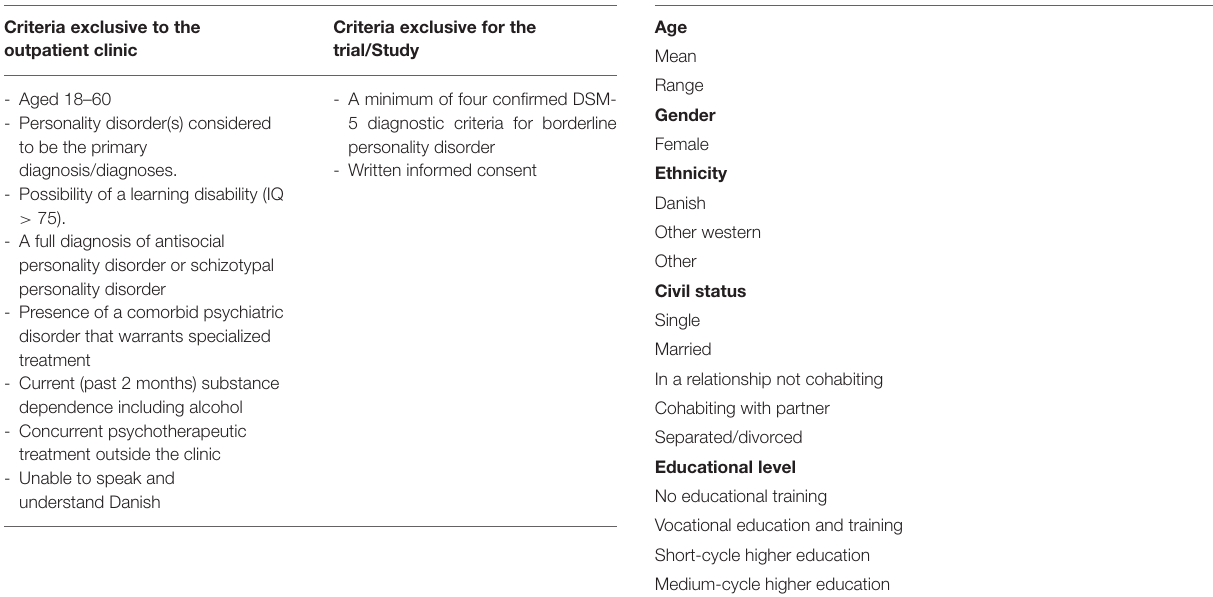
TABLE 2 | Eligibility criteria. TABLE 3 | Sociodemographic